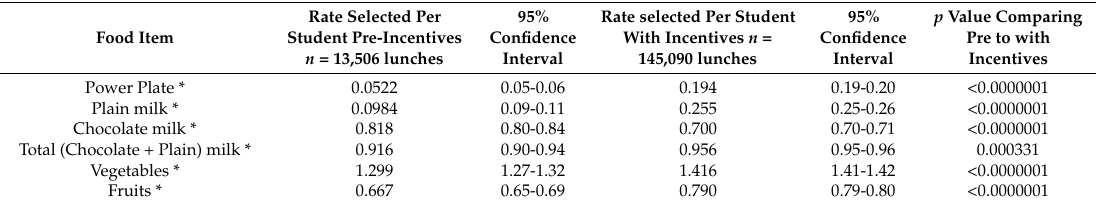
Table 2. Summary of Food Items selected by Norwood elementary students comparing pre-incentive rate and after initiating incentives. Z -tests were performed to determine significance between purchase rate before and during the intervention. p Value Comparing Rate Selected Per 95% Rate selected Per Student 95% Food Item Student Pre-Incentives Confidence With Incentives n = Confidence Pre to with n = 13,506 lunches Interval 145,090 lunches Interval